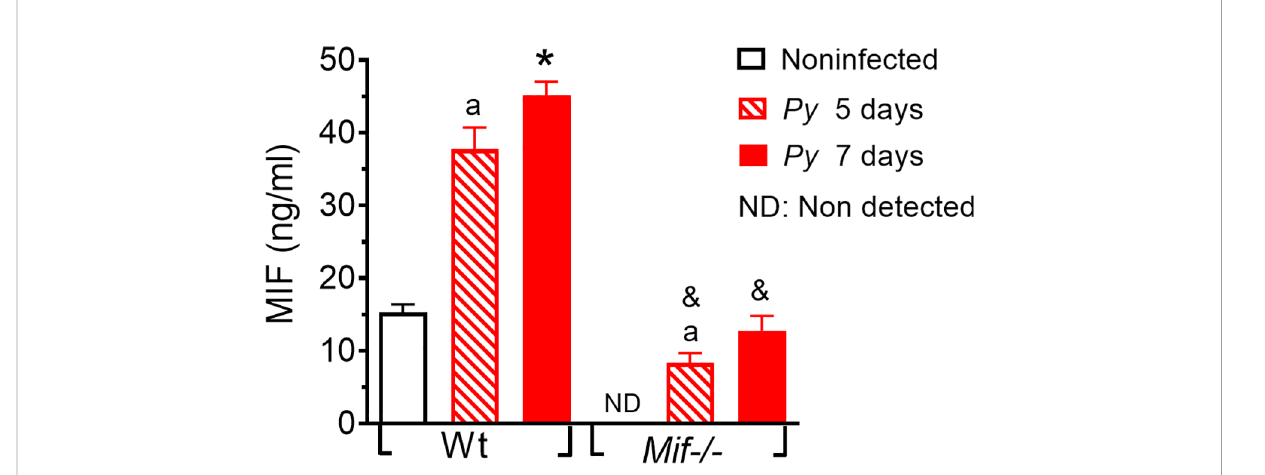
FIGURE 1 Plasmodium yoelii 17XL infection increases MIF levels in serum. Wild-type and Mif -/- mice were intravenously infected with 1×10 3 Py 17XL- parasitized erythrocytes. All experimental groups were bled at 5 and 7 days postinfection, and MIF protein levels were measured in serum. Data are expressed as the mean ± SEM and are representative of 3 independent experiments with at least 3 to 5 mice per group. Values of p < 0.05 were considered statistically signi fi cant, (a) compared with noninfected Wt mice, (*) compared with all experimental groups, (&) compared with Py 17XL at 5 days postinfection.